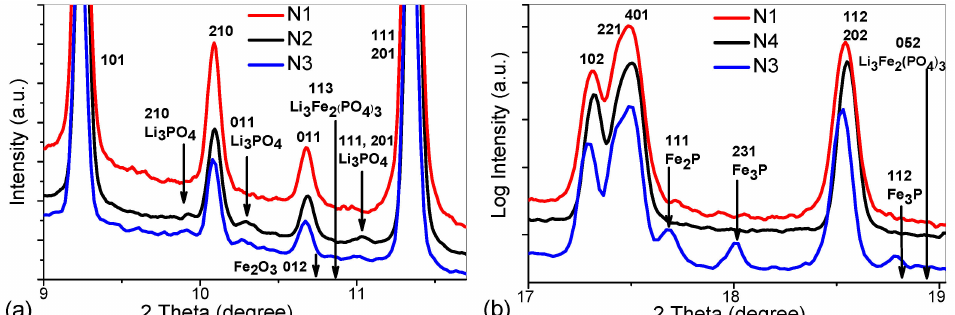
Figure 1. SXRD measurements of the developed and industrial LiFePO 4 powders, N1 and N2–4, respectively, for 2 Theta intervals 9.0–11.7 ( a ) and 17.0–19.1 ( b ). Arrows near the abscissa indicate the expected peak positions.